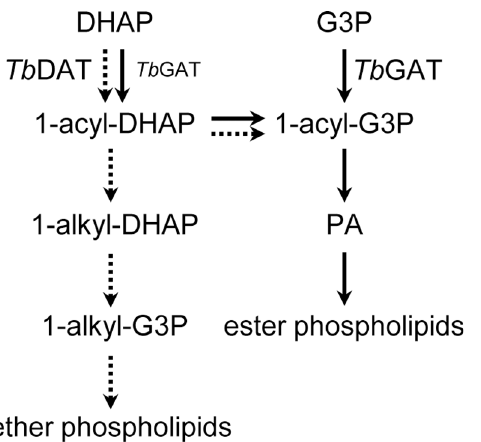
Fig 7. Contribution of Tb GAT and Tb DAT to glycerophospholipid biosynthesis. Tb DAT acylates preferentially DHAP and is involvedin the biosynthesisof ether and of ester glycerophospholipids(dotted arrow). In contrast, Tb GAT acylates both DHAP and G3P but is implicatedmainly in ester glycerophospholipid biosynthesis (solid arrow) [31].